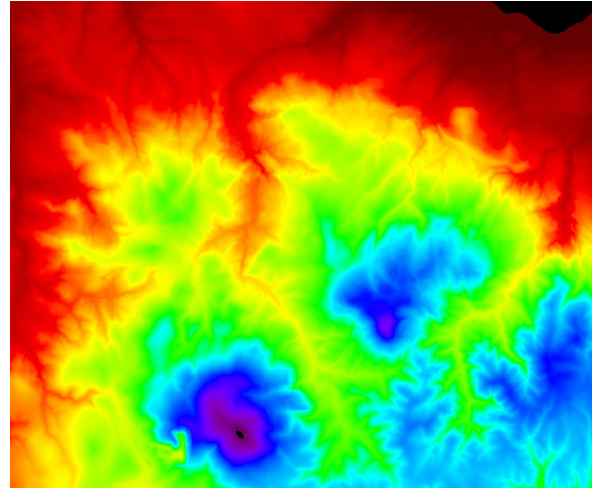
Figure 7: The recent local DEM over the test site.